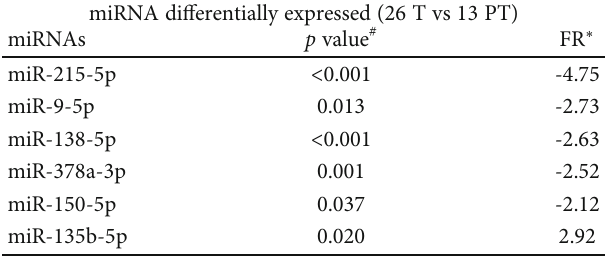
Table 2: miRNAs di ff erentially expressed in tumoral ( n = 26 ) vs peritumoral ( n = 13 ) tissues. miRNAs are ordered accordingly to increasing fold regulation.